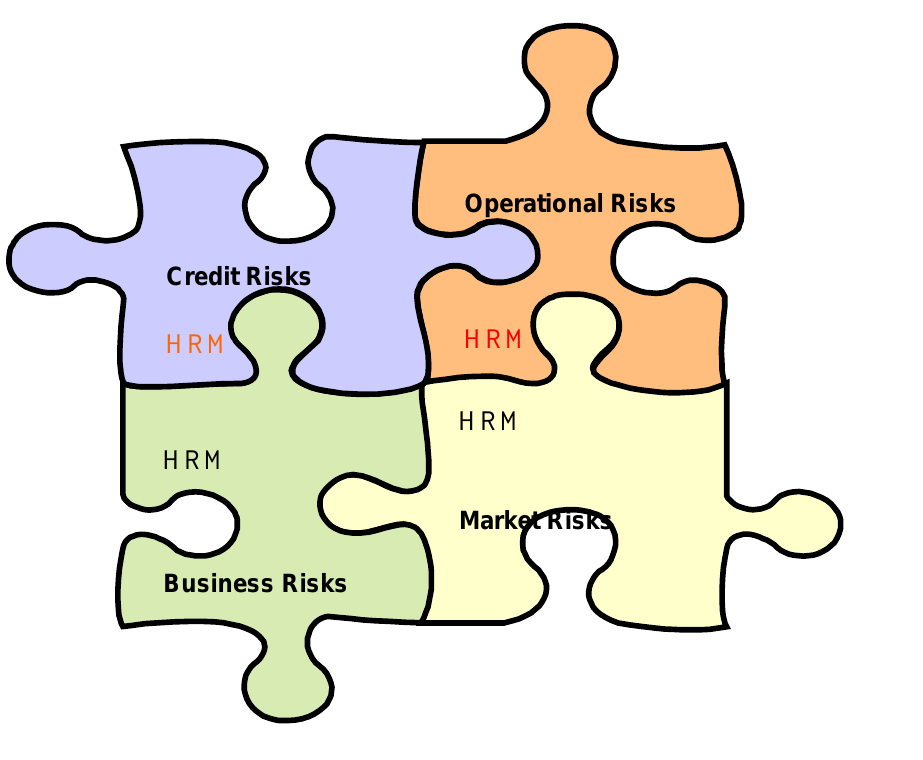
Figure 3: The jigsaw holistic risk management